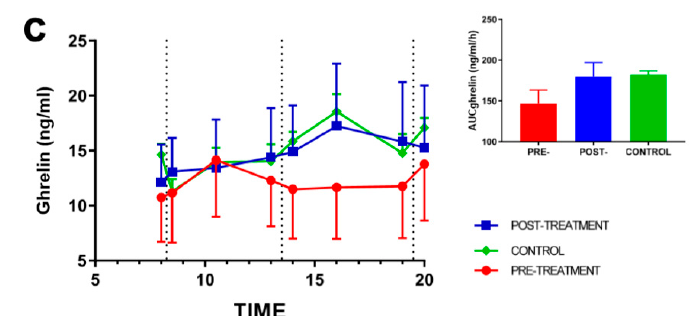
Figure 2. Diurnal synthesis rhythms of ( a ) glucose, ( b ) leptin, and ( c ) ghrelin in the control (green line) and obese subjects at baseline (red line) and after 12 weeks of hypocaloric dietary treatment (blue line). The vertical dotted lines indicate the time of breakfast, lunch, and dinner. Mean ± standard error The differences between the groups were analyzed by a two-way (time × group) repeated-measures analysis of variance (ANOVA).